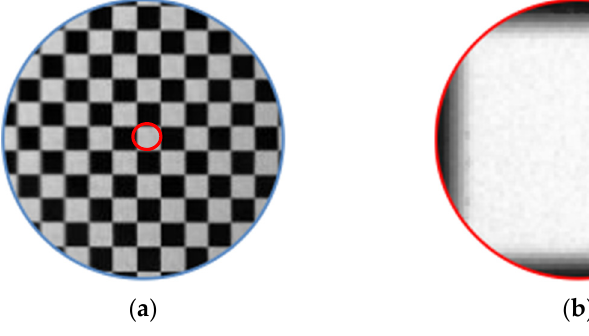
Figure 5. ( a ) Example of corrected checkerboard image; ( b ) the image becomes blurred due to the environment and hardware; ( c ) partial enlargement of the corrected image after parameter